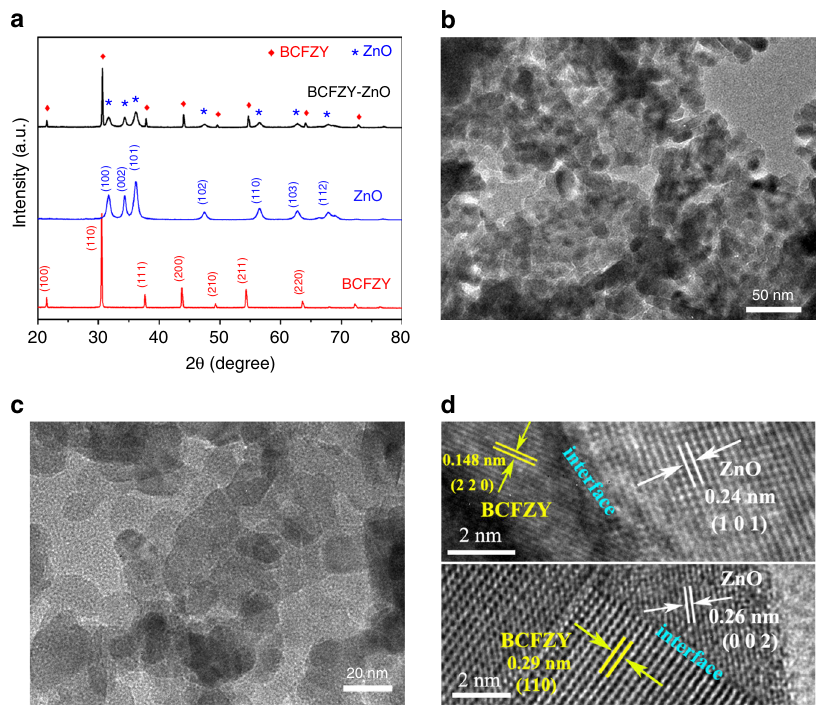
Fig. 1 Structure and morphology characterization ( a ) XRD patterns of the prepared BCFZY, commercial ZnO and BCFZY-ZnO composite, ( b ) and ( c ) TEM images of the BCFZY-ZnO composite, ( d ) Two typical HR-TEM images of the BCFZY-ZnO composite showing the interfaces between BCFZY and